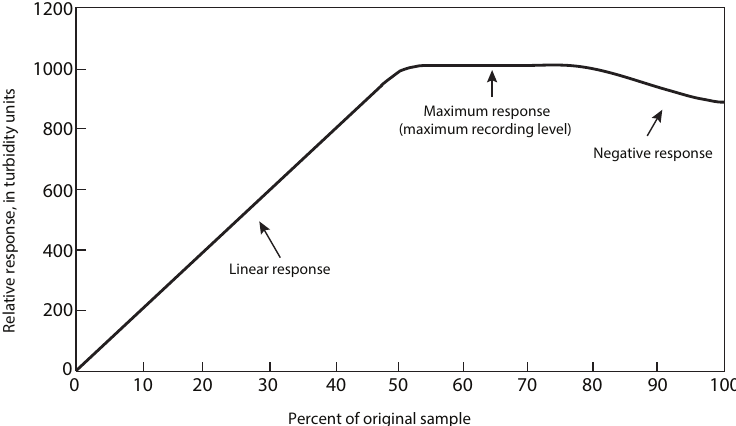
Figure 2. Generic response curve of a single-detector turbidity instrument showing three turbidity responses. The turbidity response is dependent on the characteristics of the turbidity instrument as well as the concentration of material (e.g., sediment) in the sample. The “original sample” on the horizontal axis refers to a water sample containing a high concentration of sediment or some other light-scattering material. As one moves from right to left on this axis, this original sample is diluted with increasing amounts of clear turbidity-free water. “0” thus indicates clear water and increasing numbers indicate increasing sediment or particle concentrations (modified from ASTM,